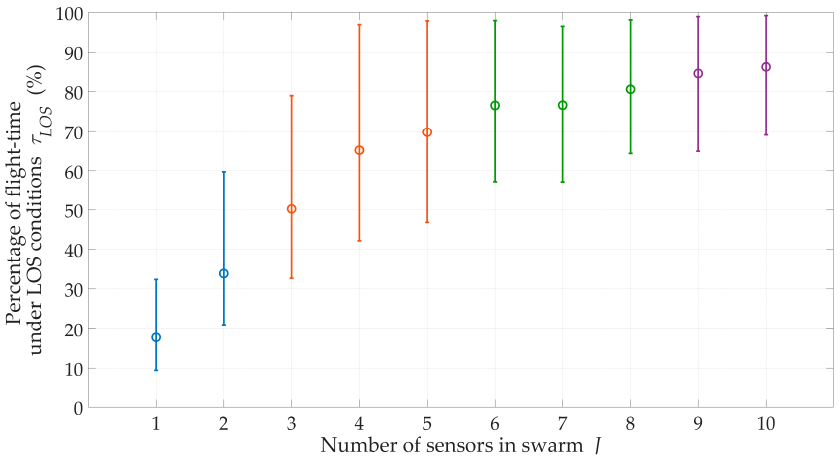
Figure 9. Percentage of flight-time under LOS conditions versus number of sensors in swarm for suburban area.